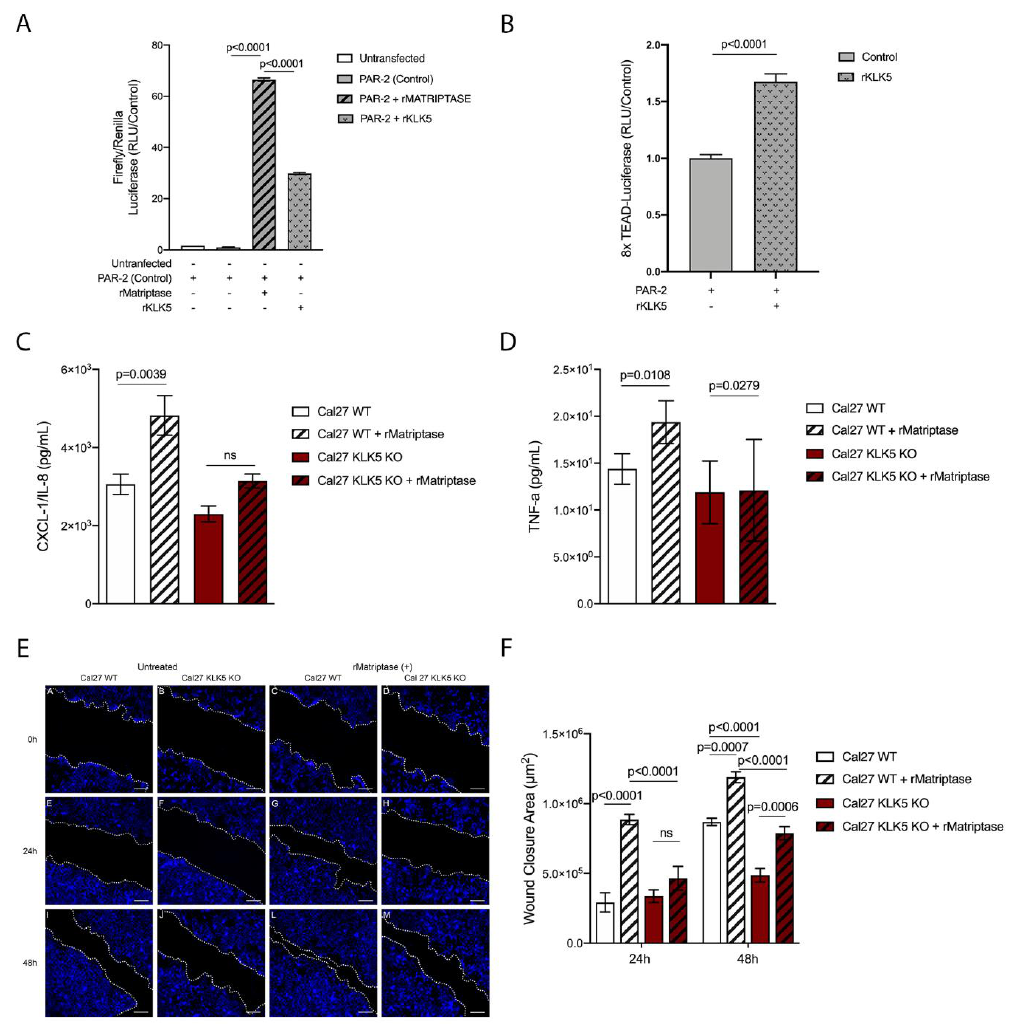
Figure 5. KLK5 activates YAP1-TAZ/TEAD transcription via PAR-2 and induces matriptase-mediated release of IL-8 and cell migration in OSCC cells. ( A ) KLK5-mediated PAR-2 activation analysis. HEK293T cells were transfected with pCDNA 3.1-PAR-2, pRL-Renilla luciferase and SRE-Firefly luciferase reporter plasmids and treated with hrKLK5 for 6 h, PAR-2